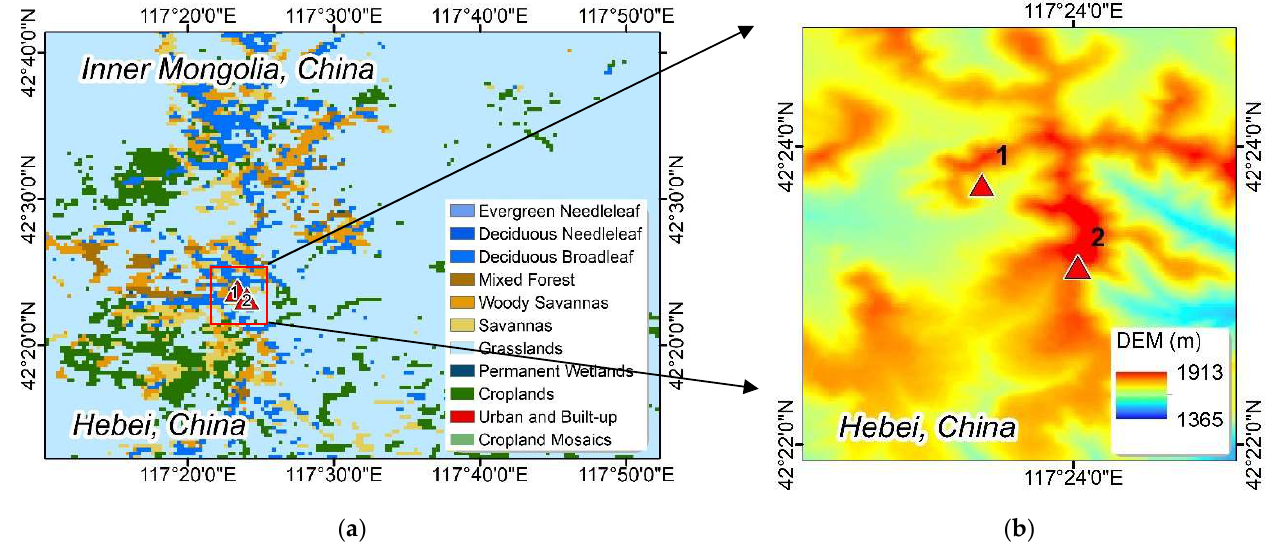
Figure 1. Land cover of the study area in SFP ( a ) and the SRTM 30 m DEM of the validation stations ( b ). The land-cover map was obtained from the MODIS land-cover product MCD12Q1 in 2018, in which the International Geosphere–Biosphere Program (IGBP) global vegetation classification was chosen. The two in situ sites in SFP are indicated by the red triangles.